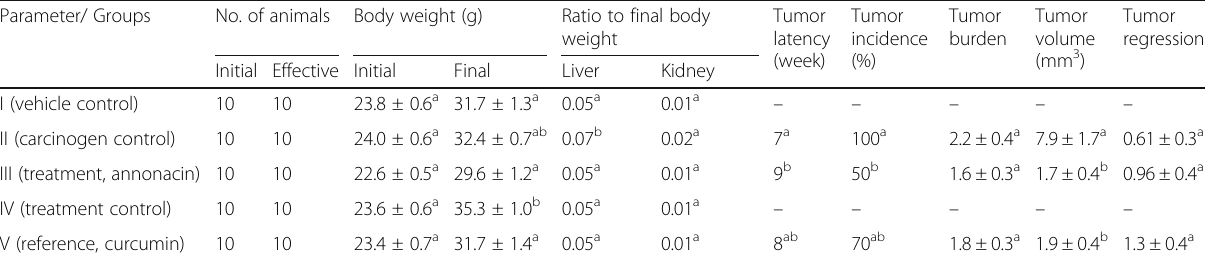
Table 1 Effect of annonacin on the promotion stage of DMBA/TPA-induced mouse skin tumorigenesis after 22 weeks of treatment Parameter/